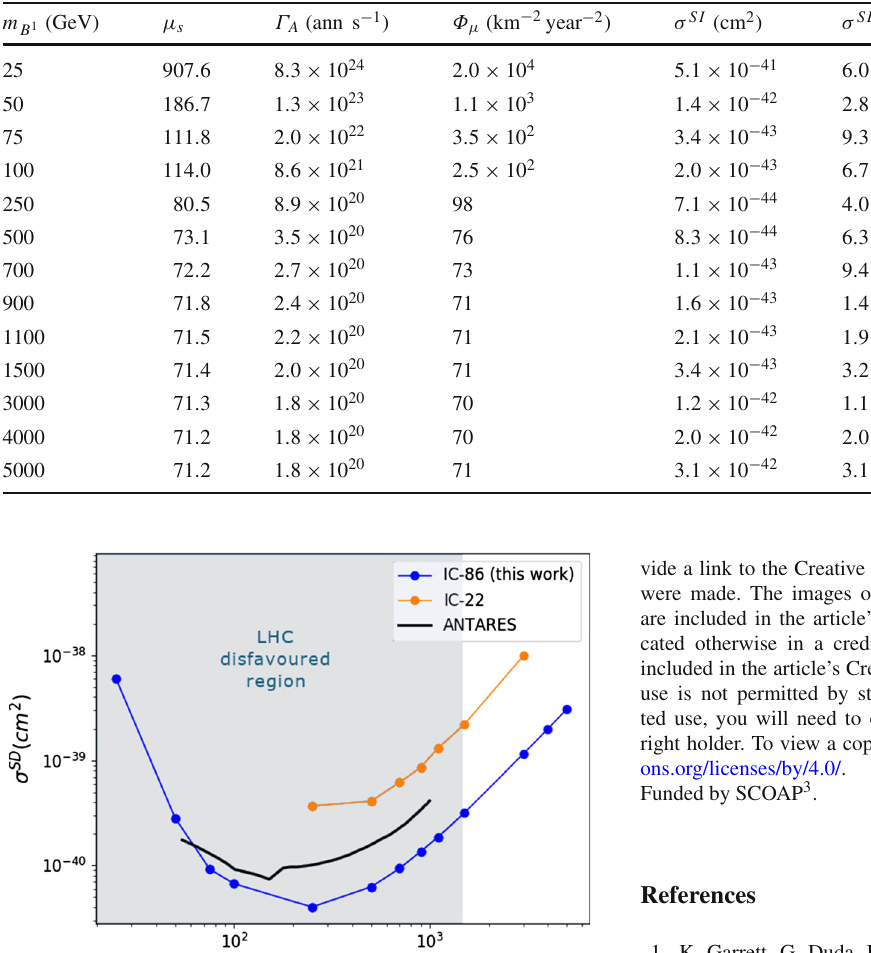
Table 2 90% confidence level upper limits on the signal, the annihi- lation rate in the Sun, the muon flux at the detector above 1 GeV and the spin independent and spin dependent B 1 -proton cross sections for